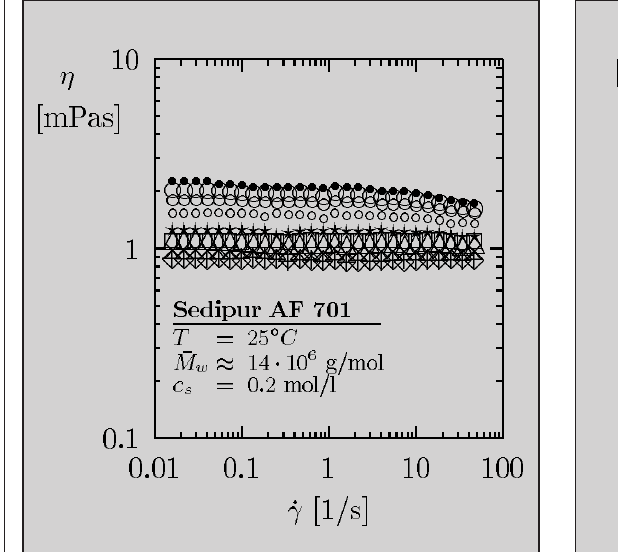
Figure 4 (right): The zero shear viscosity as a function of the polymer concentrations for different polymer solvent